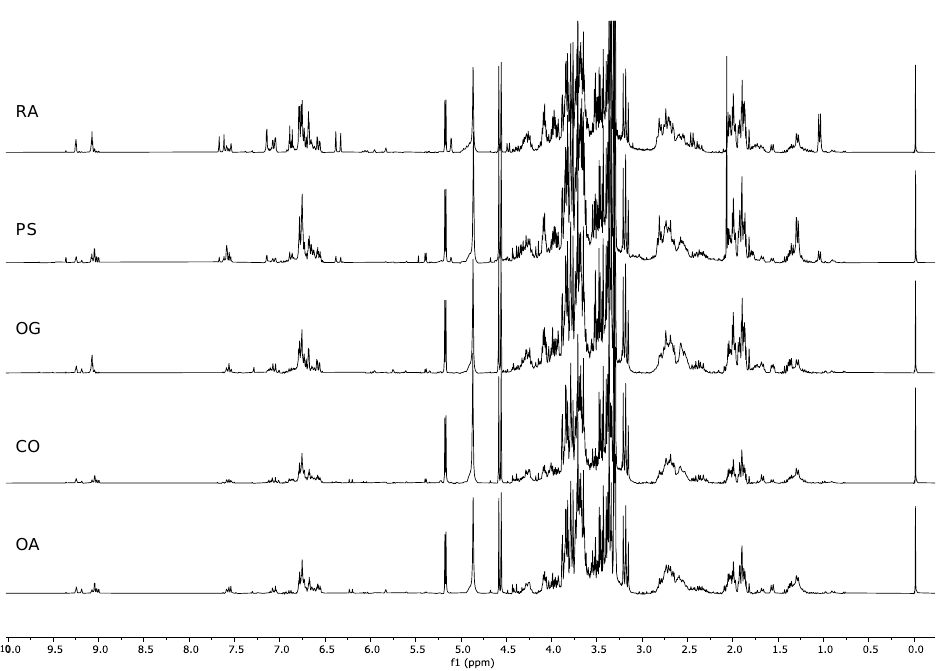
Figure 6. 1 H-NMR spectra of Group IV: Ogliara (OA), Carolea (CO), Ogliastro (OG), Pisciottana (PS), and Racioppa (RA).